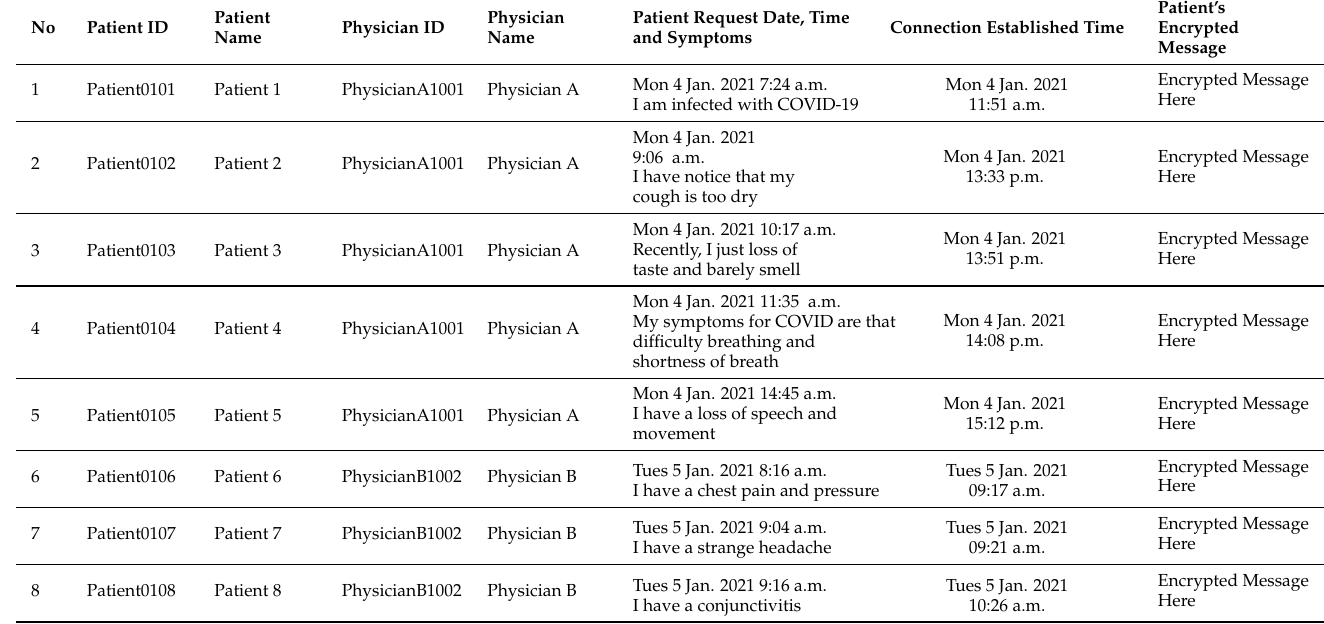
Table 1. Tele-COVID patient-physician communication data in the county